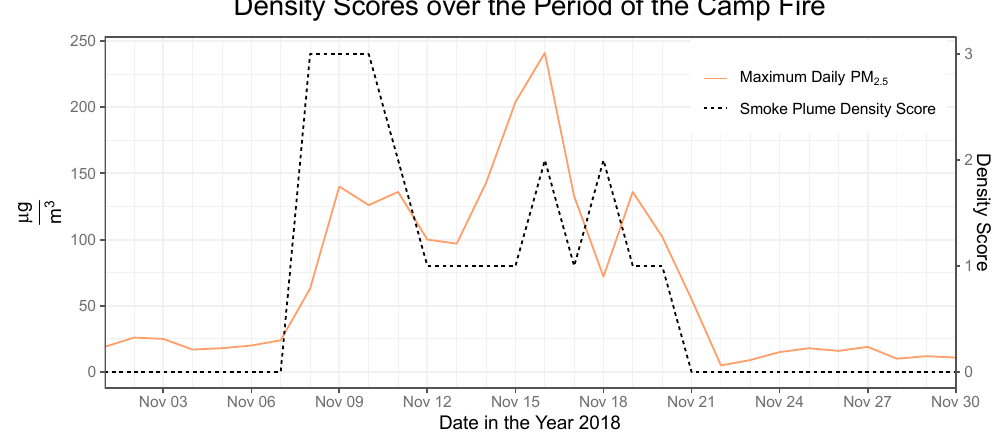
Figure 3. Time series plot of PM 2.5 concentrations and smoke plume density in San Francisco during the Camp Fire.